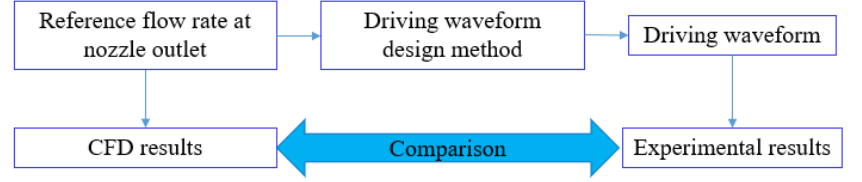
Figure 4. Verification approach of driving waveform design method. The fluid viscosities were measured by a visualization rheometer (MCR302, Anton Paar, Graz, Austria), and the power-law model shown as (18) was used to fit the fluid viscosities.